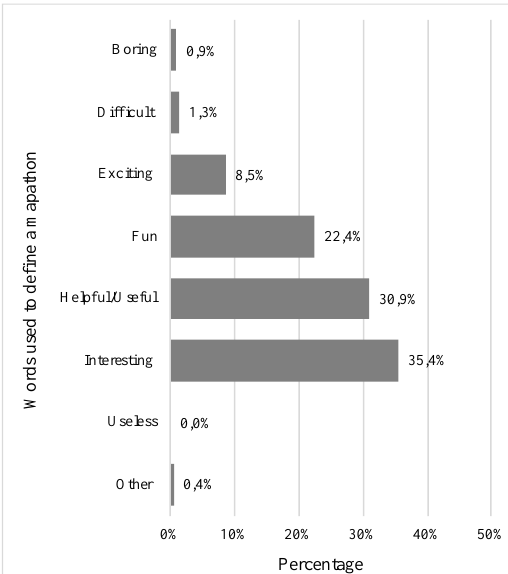
Figure 1. Number of mapathons students attended